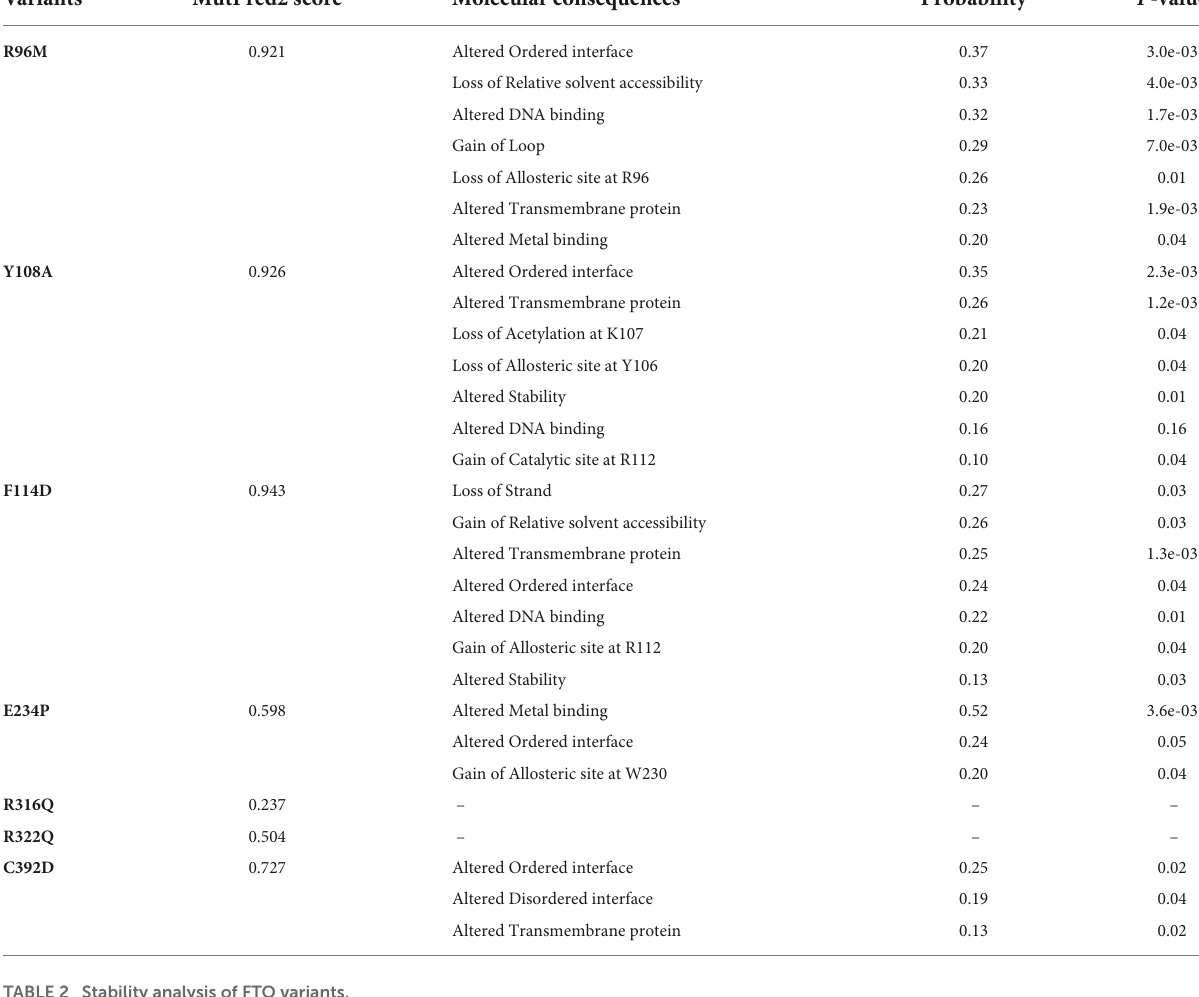
TABLE 1 Functional annotation of FTO variants.